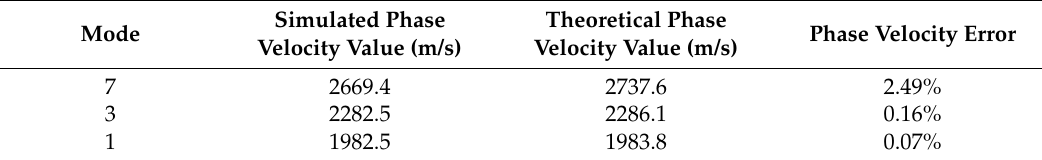
Table 2. Phase velocity of modes.